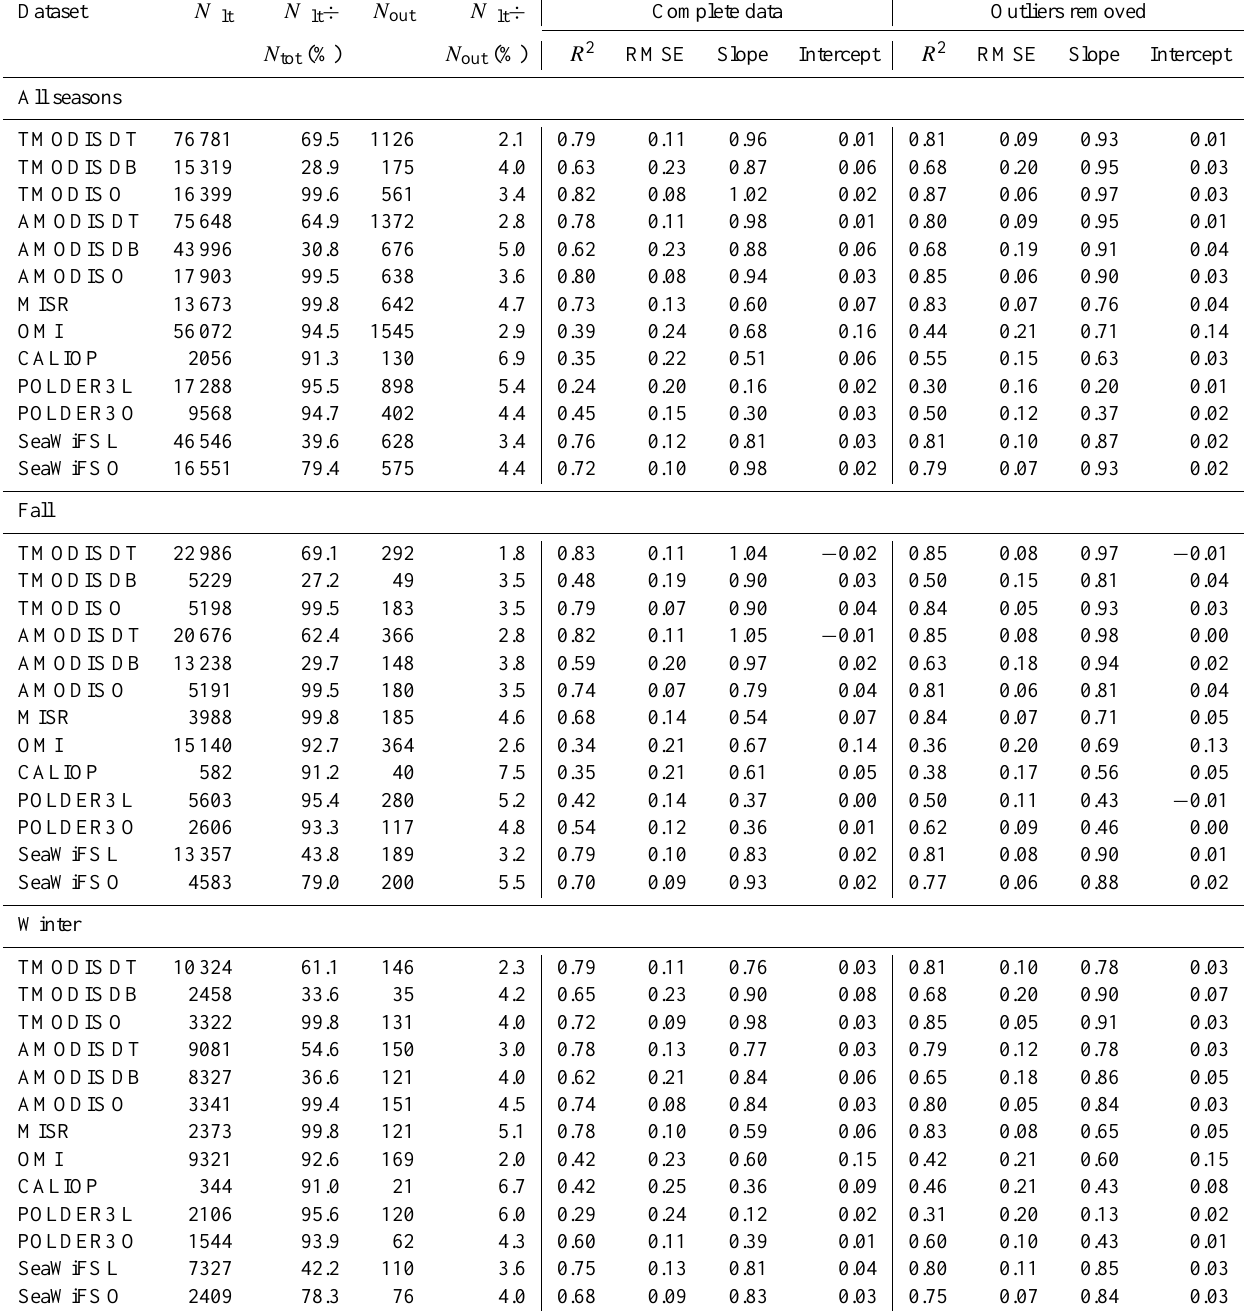
Table 3. Statistics of the studied aerosol datasets based on all AERONET stations during the period of 2006-06-07 and 2010-12-11. “ N tot ” indicates the total number of the collocated spaceborne AOD – AERONET AOD data points, while “ N filt ” indicates the number of data points after filtering (screening) the spaceborne data by QA as described in Sect. 4 and Table 2. “ N out ” is the total number of the possible data outliers determined as explained in Sect. 5. The last 8 columns present the statistics on the collocated data based on regression fits also plotted in Fig. 6. Please see the Supplement for a breakdown of the listed statistics based on nominal ranges of AOD